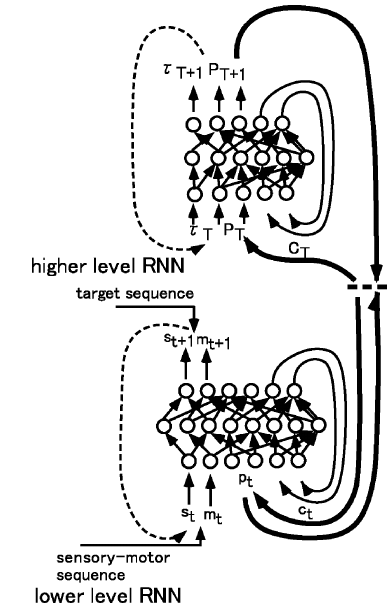
Figure 6. The complete architecture of hierarchically organized RNNPB .